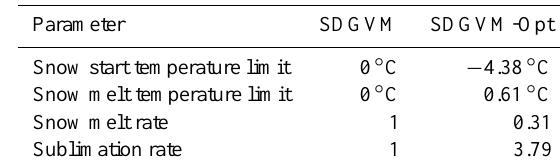
Table 3. Original and optimized parameters of the SDGVM